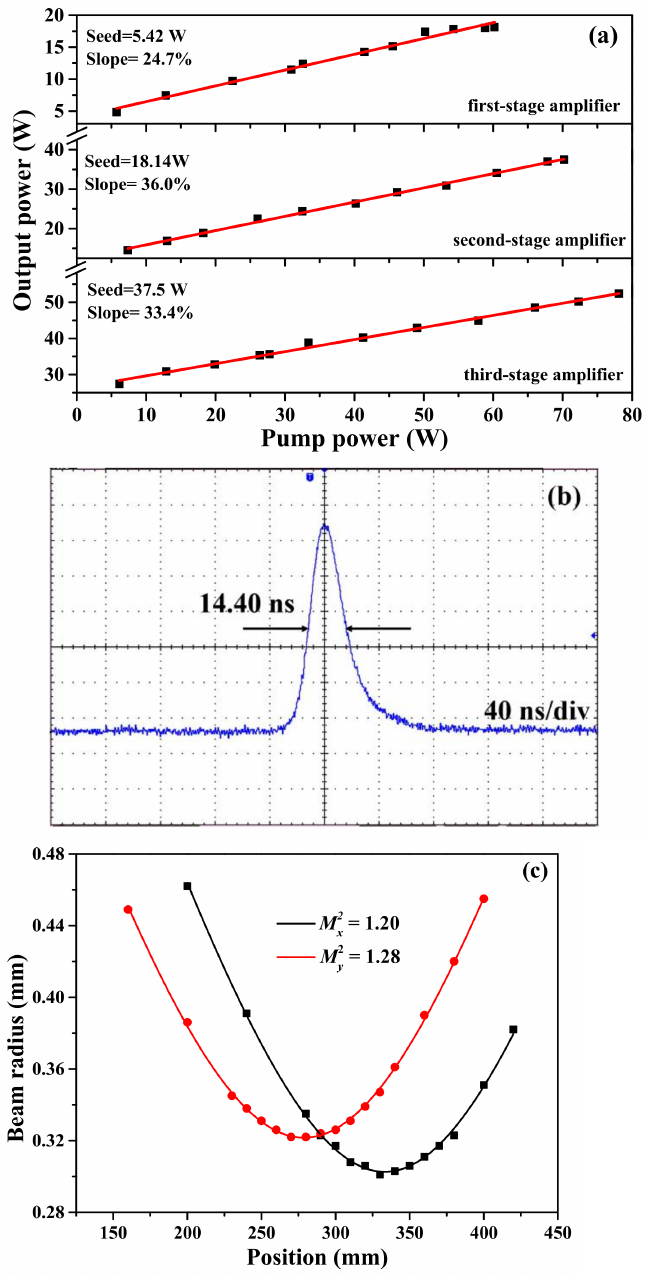
Figure 4. ( a ) Output powers, ( b ) pulse width, and ( c ) beam quality factor M 2 of three-stage Ho:YAG